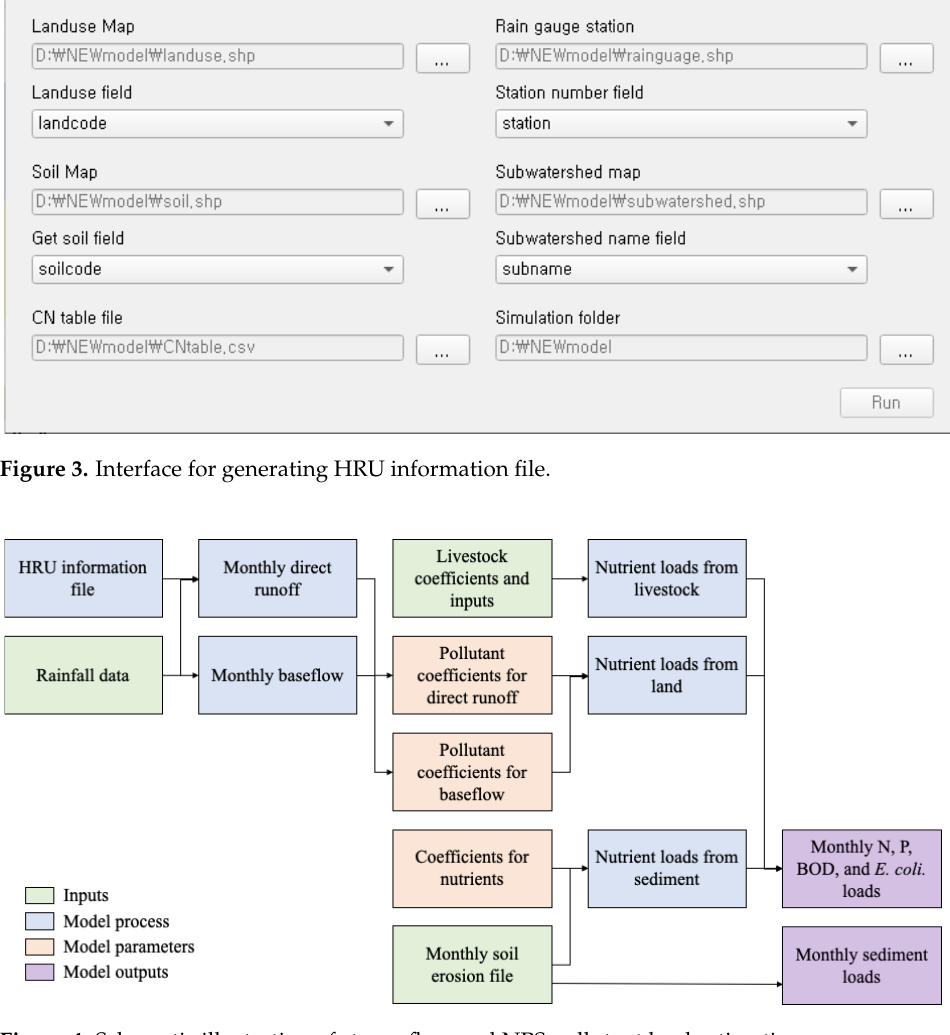
Figure 4. Schematic illustration of streamflow and NPS pollutant load estimation.